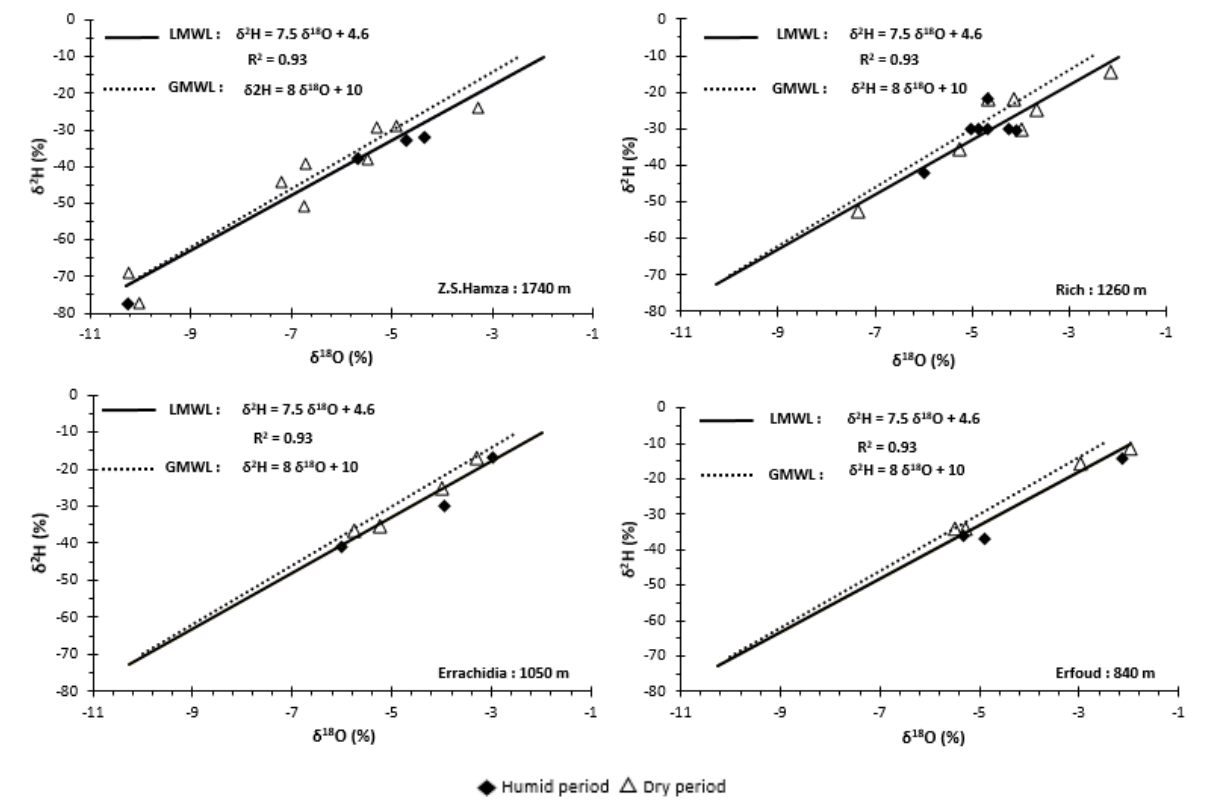
Figure 11. Seasonal variation in stable isotopes in precipitation observed during rainy episodes in the wet season (October to April) and dry period (May to September) collected between December